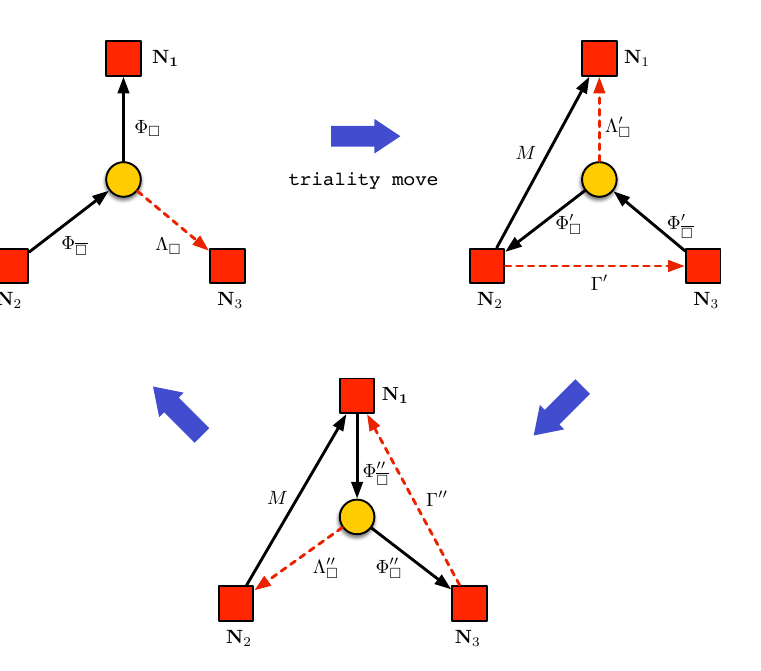
in the determinant (cid:6)